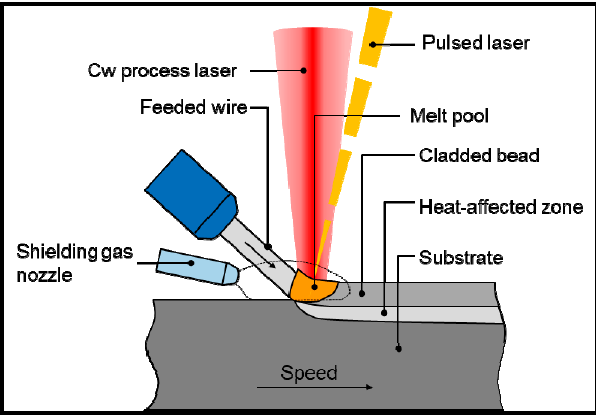
Figure 1. Process principle of dual beam Laser Metal Deposition with wire (LMD-w).